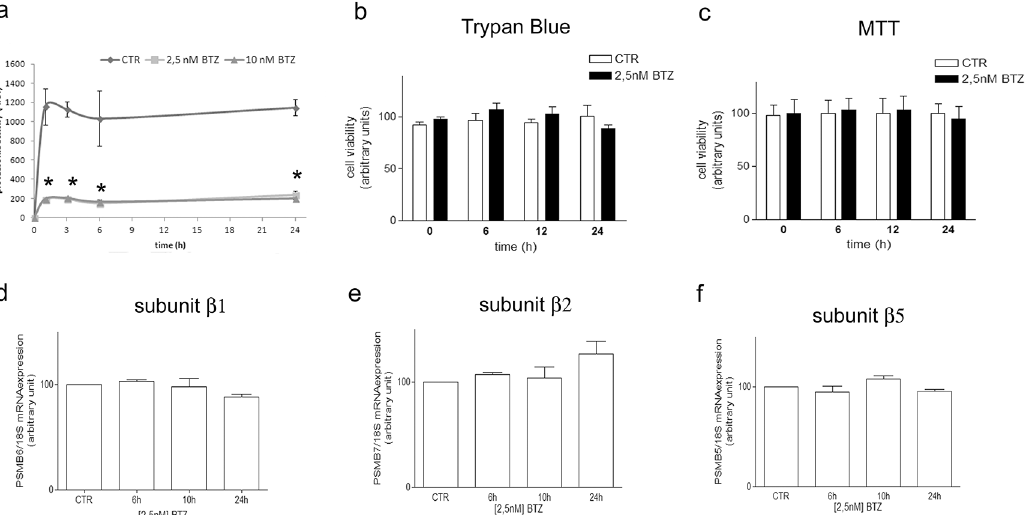
Fig 1. A low dose of BTZ decreases proteasome activity with no effect on cell viability. HTLA-230 NB cells were treated with 2.5 nM BTZ for 1 – 24 h. The chymotrypsin-like protease activity was measured in living cells by using the fluorescent probe TED. The efficacy of 2.5 nM BTZ in inhibiting proteasome activity was compared with the effect induced by a higher dose of BTZ (10 nM) (a). The number of viable cells were detected by Trypan blue dye exclusion test (b) and MTT assay (c). mRNA level of proteasome subunit β 1 (d), subunit β 2 (e), subunit β 5 (f) were measured by means of RT-PCR. Total RNA was extracted from HTLA-230 cells treated with 2.5 nM BTZ up to 24 h, as indicated. PCR products were separated by electrophoresis and the relative intensities of the bands were normalized to 18S expression. The graphs show the mean value of three independent experiments (mean ± SE); * p < 0.01 vs untreated cells for both 10 and 2.5 nM